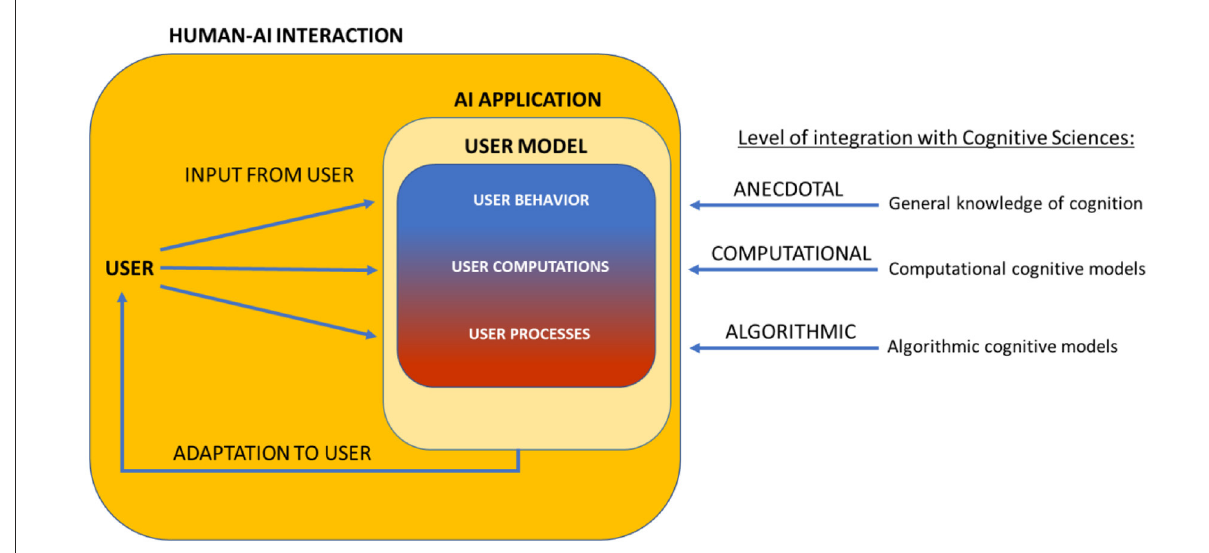
FIGURE1 User models in Human-AI interaction can represent the user to different degrees depending on how strongly they are integrated with models from cognitive sciences. At the anecdotal level the user model is inspired from general knowledge of human cognition and does not represent the cognitive state of the user. At the computational level, computations of the user are represented. At the algorithmic level, the user model also incorporates the cognitive processes of the user.